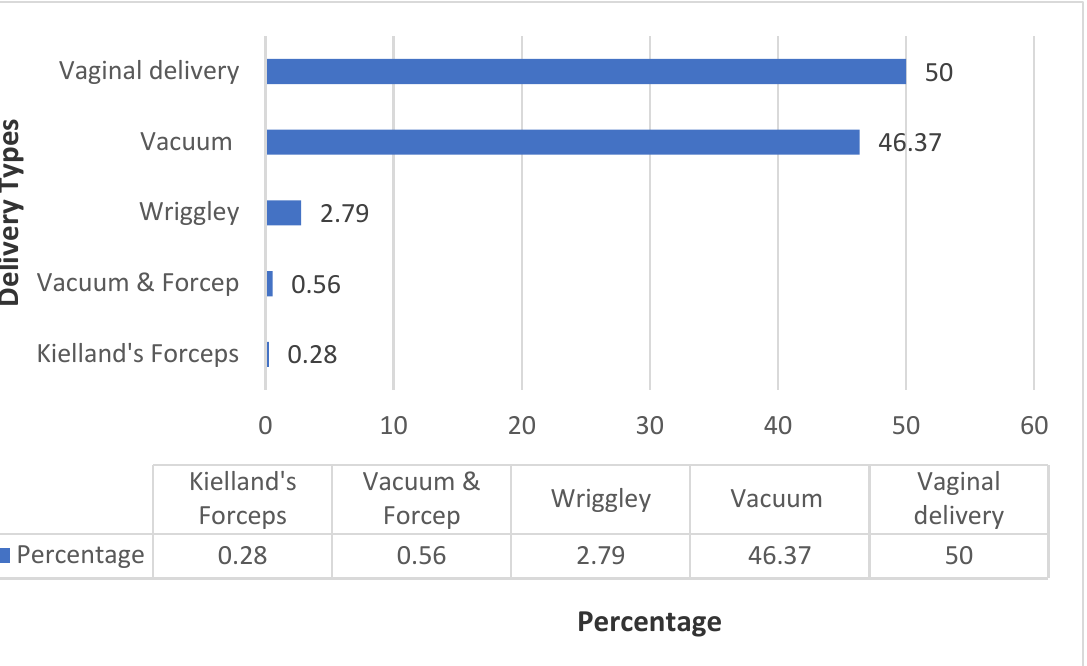
Table 4. Comparison of the sociodemographic and clinical characteristics among women that had forceps and vacuum deliveries.